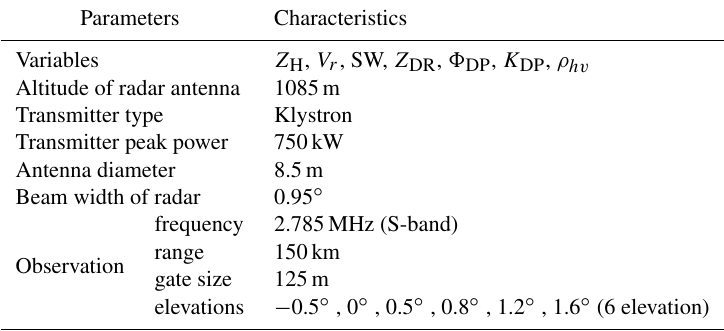
Table 1. Specifications for dual-polarization radar in Bislsan.